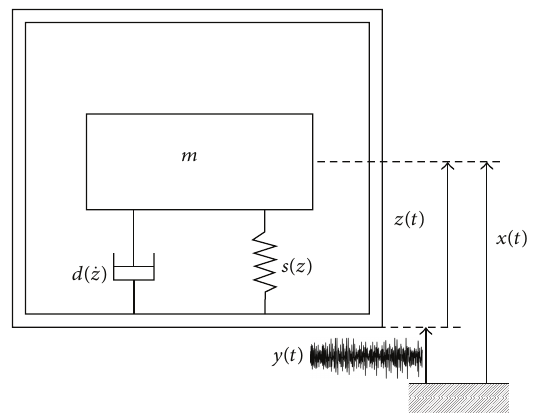
Figure 1: Lumped parameter model of an inertial electromagnetic energy